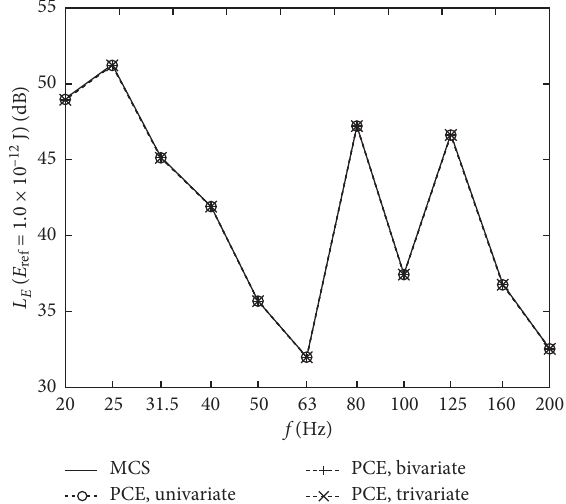
Figure 8: Mean of the energy-level response of the 1/3 Oct spectrum.